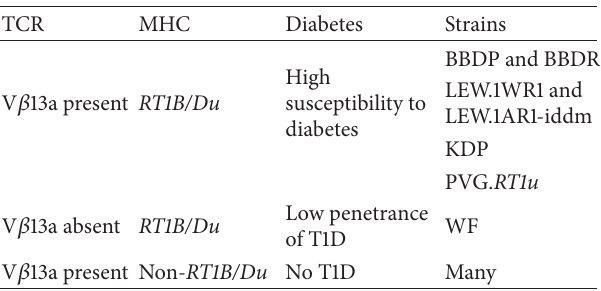
Table 1: Type 1 diabetes frequency in rats as a function of MHC and TCR